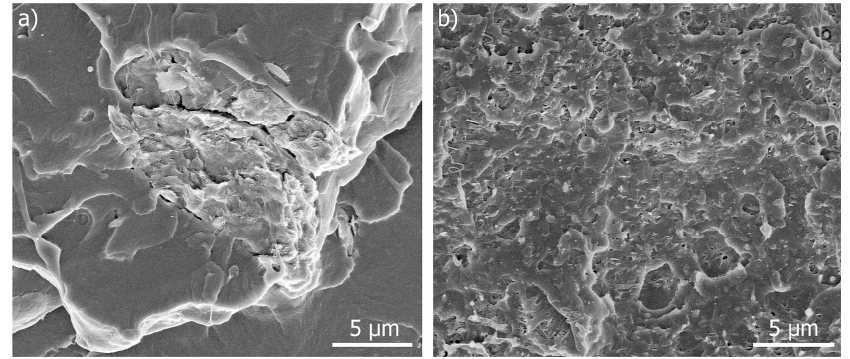
Figure 6. HR-SEM images at higher magnification of ( a ) PLA-ChNC showing poor dispersion and distribution of ChNC and ( b ) PLA-TEC7.5-ChNC showing better dispersed and distributed ChNC as white dots.